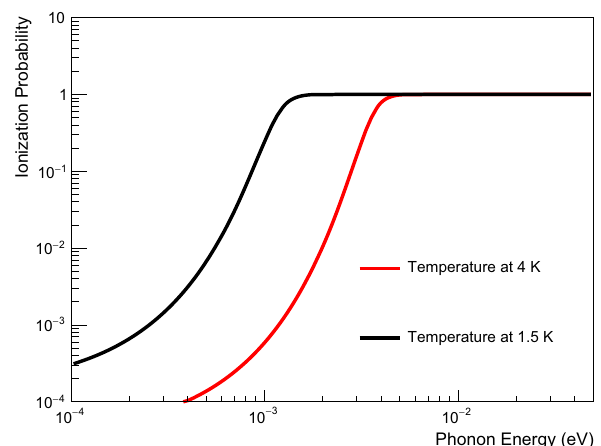
Fig. 8 Shown is the absorption probability as a function of phonon energy in a given Ge detector. Three impurity levels are displayed and the difference in the absorption probability is seen when the energy of phonons is greater than 0.001 eV